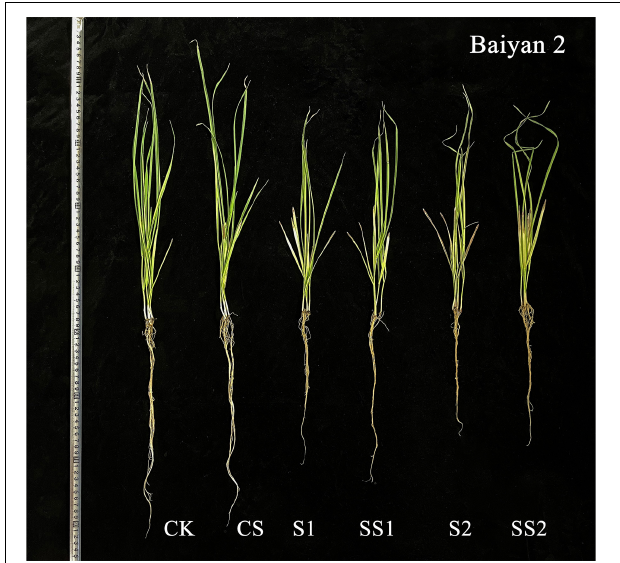
FIGURE 10 | Effects of Spd application on the growth under Salt Stress in salt-sensitive cultivar Caoyou 1. CK, Nutrient solution + distilled water; CS, Nutrient solution + 0.75 mM Spd; S1, 70 mM salt + distilled water; SS1, 70 mM salt + 0.75 mmol/L Spd; S2, 100 mM salt + distilled water; SS2, 100 mM salt + 0.75 mmol/L Spd.